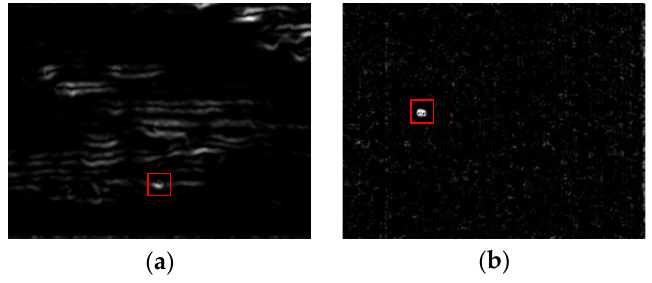
Figure 1. Illustration of the local structure weight map.